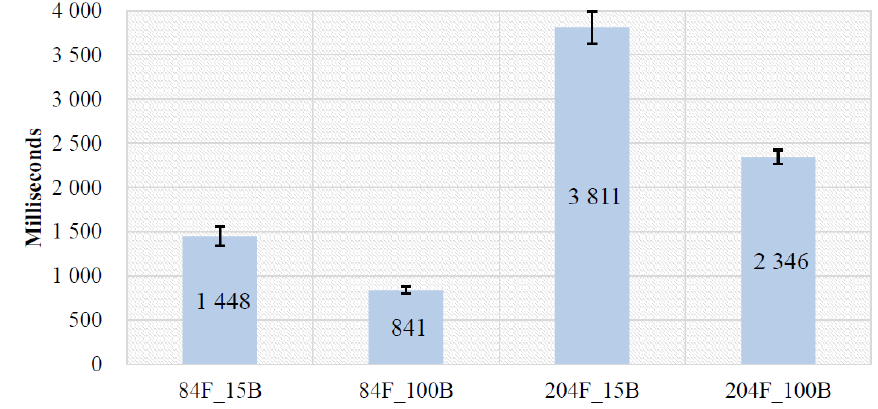
Figure 9. Effects of low battery on Moto 360 (lower is